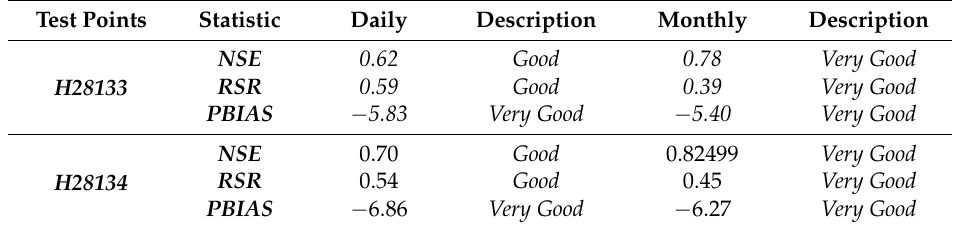
Table 5. Statistical parameters of performance in series from daily and monthly data for the two test points (H28133 and H28134) the evaluation period from 1 January 1990 to 31 December1999.